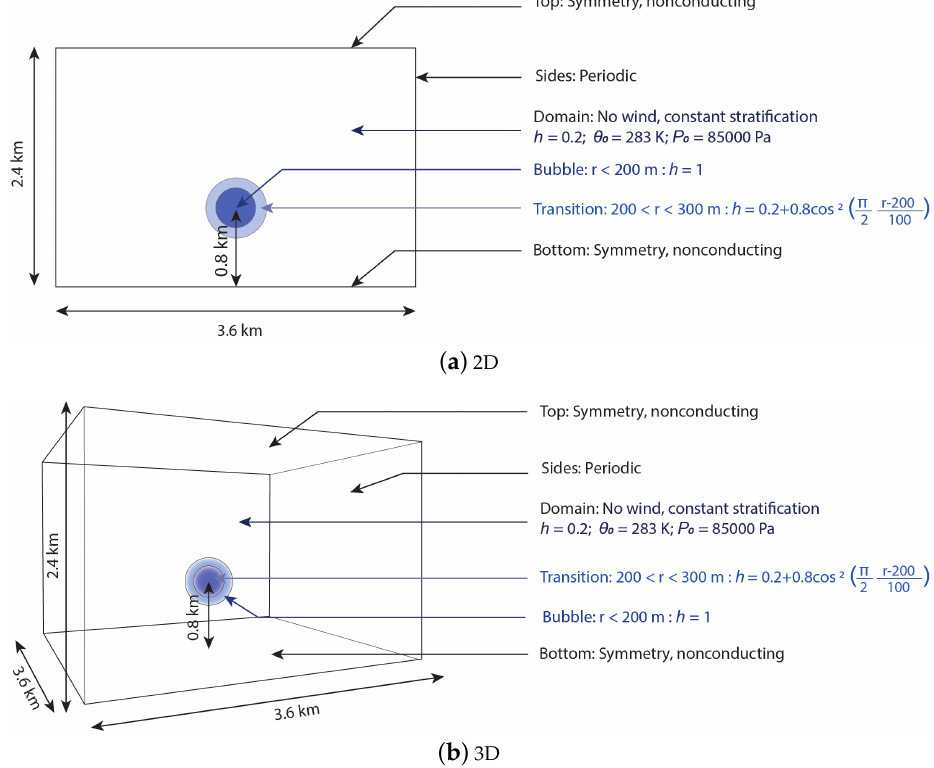
Figure 3. Configurations of the rising moist thermal